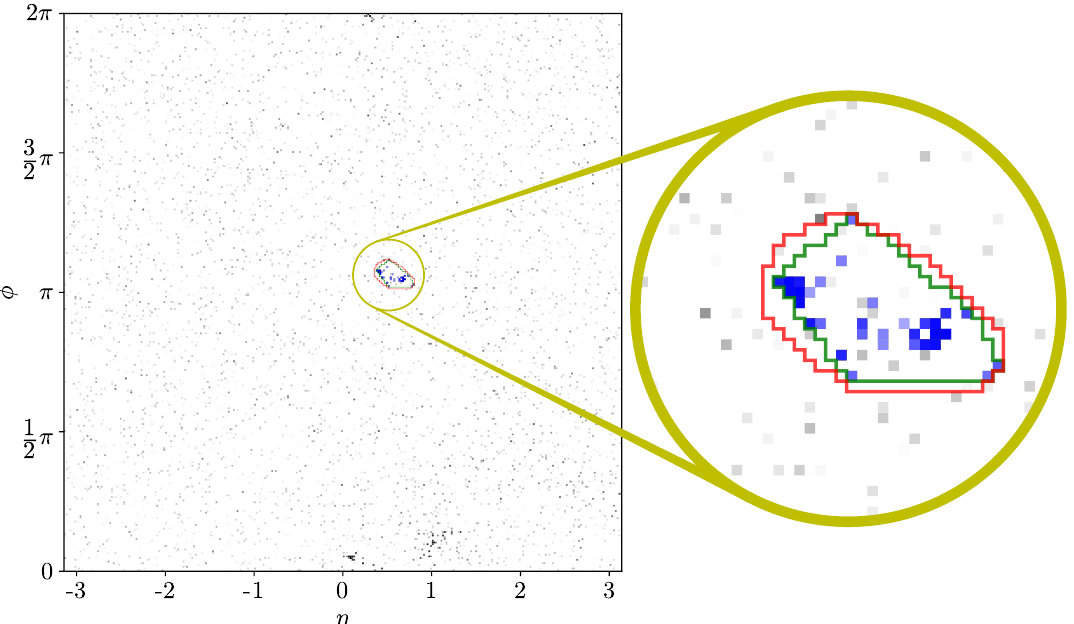
Figure 5. Another grayscale-inverted event image. The yellow circle has R = 0 . 4 , which is magni- fied six times for clearer visibility. The Higgs boson has p T = 927 GeV. The green contour indicates the input mask we constructed in convex hull shape, and the red one indicates the output enlarged by one pixel around its boundary. Reconstructed jets inside the red contour has m = 125 GeV and p T = 927 GeV, as compared to the trimmed one of m = 127 GeV and p T = 934 GeV.